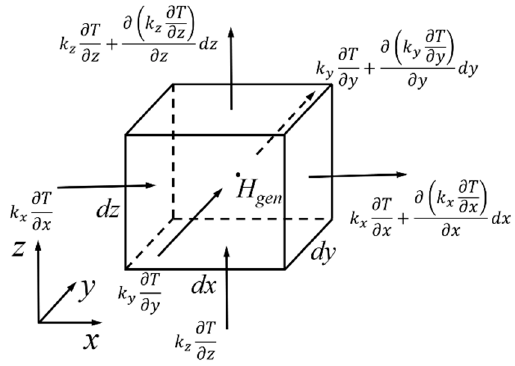
Figure 3. The temperature change of the heated surface of the base metal unit .